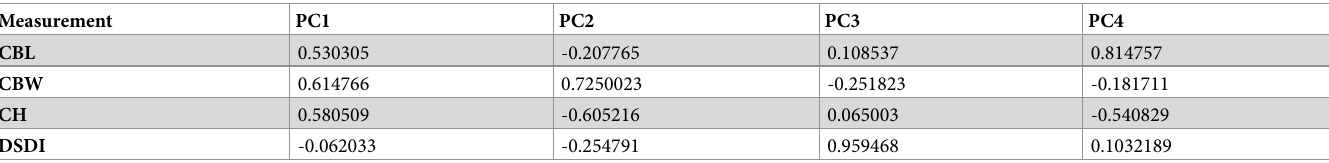
Table 2. Coefficients of the PCA analysis run on the theropod teeth dataset published by Gerke and Wings [39].